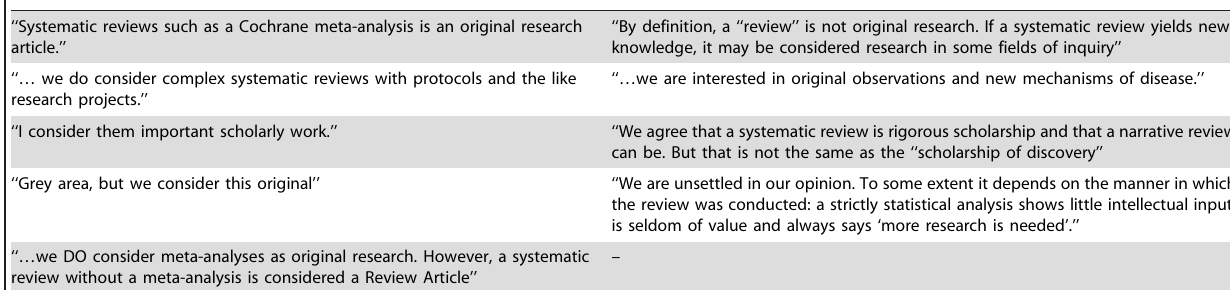
Table 3. Comments illustrating editors’ attitudes towards systematic